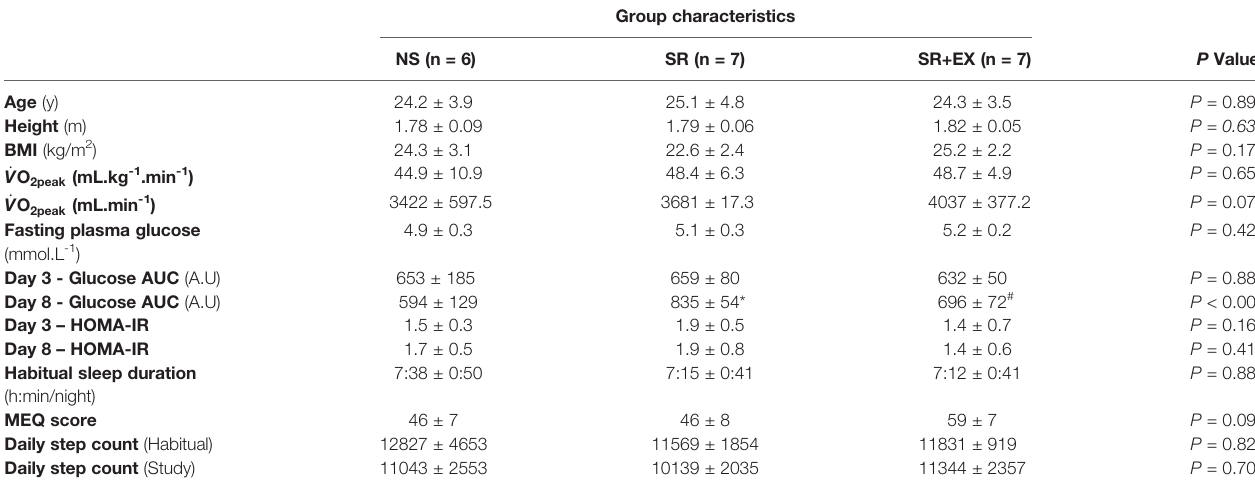
TABLE 1 | Baseline characteristics of